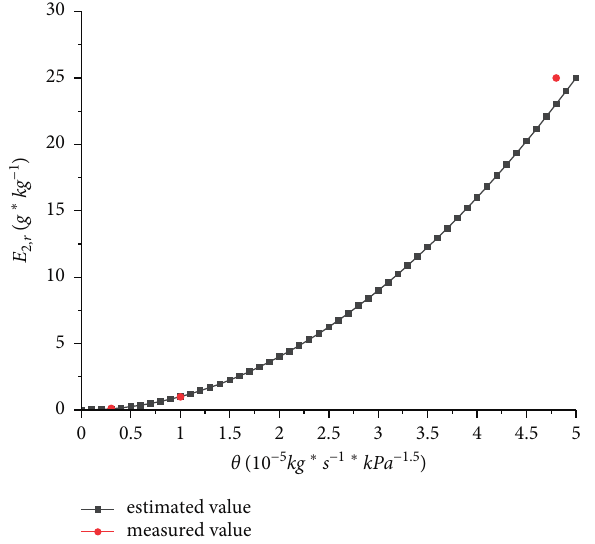
Figure 3: CO reference emission index. E measurement value, black box as the estimated value.